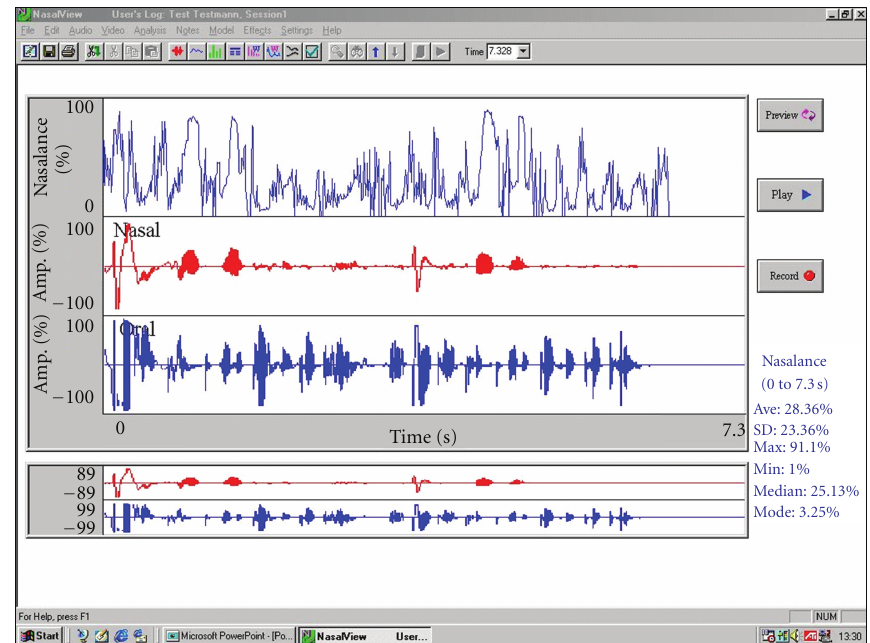
Figure 1: Sample screenshot of the NasalView system showing oszillograms for oral, nasal, and nasalance curves recorded realtime and nasalance statistic for a nonnasal test item.